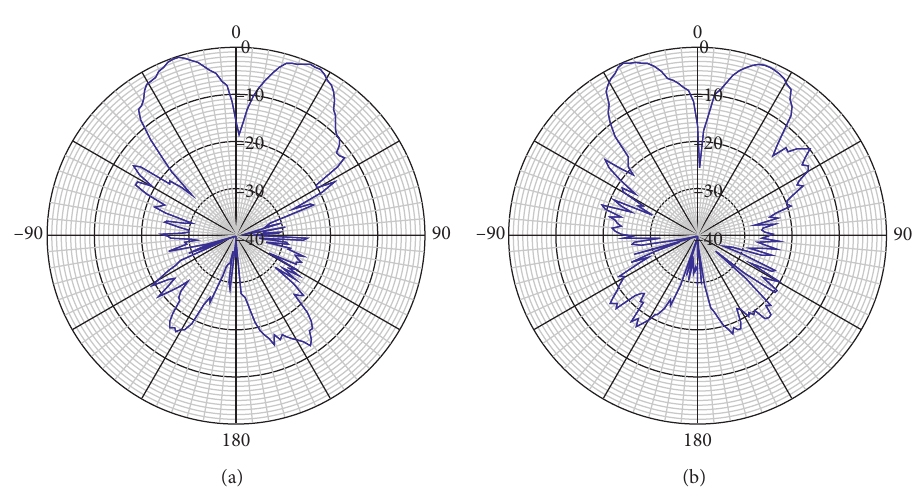
Figure 10: Copolarized radiation pattern (DIF.) in y - z plane at (a) f � 27GHz and (b) f � 28GHz.